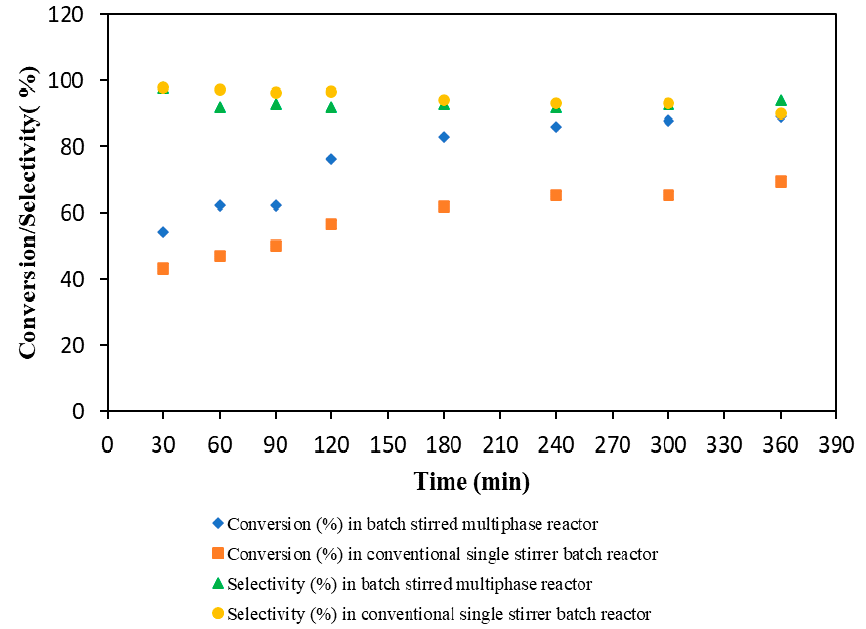
Figure 9. Comparison of batch stirred multiphase reactor with conventional single stirrer PTC batch reactor. Epichlorohydrin 0.1 mol, n-decane 0.03 mol, toluene 150 cm 3 , guaiacol 0.1 mol, sodium hydroxide 0.2 mol, sodium chloride 0.6 mol, tetra-n-butylammonium bromide 0.14 mol, and water 150 cm 3 . Temperature 40 °C, novel PTC reactor speed of agitation 60 rpm for all three phases, conventional PTC reactor speed of agitation 1200 rpm, and reaction time 6 h.